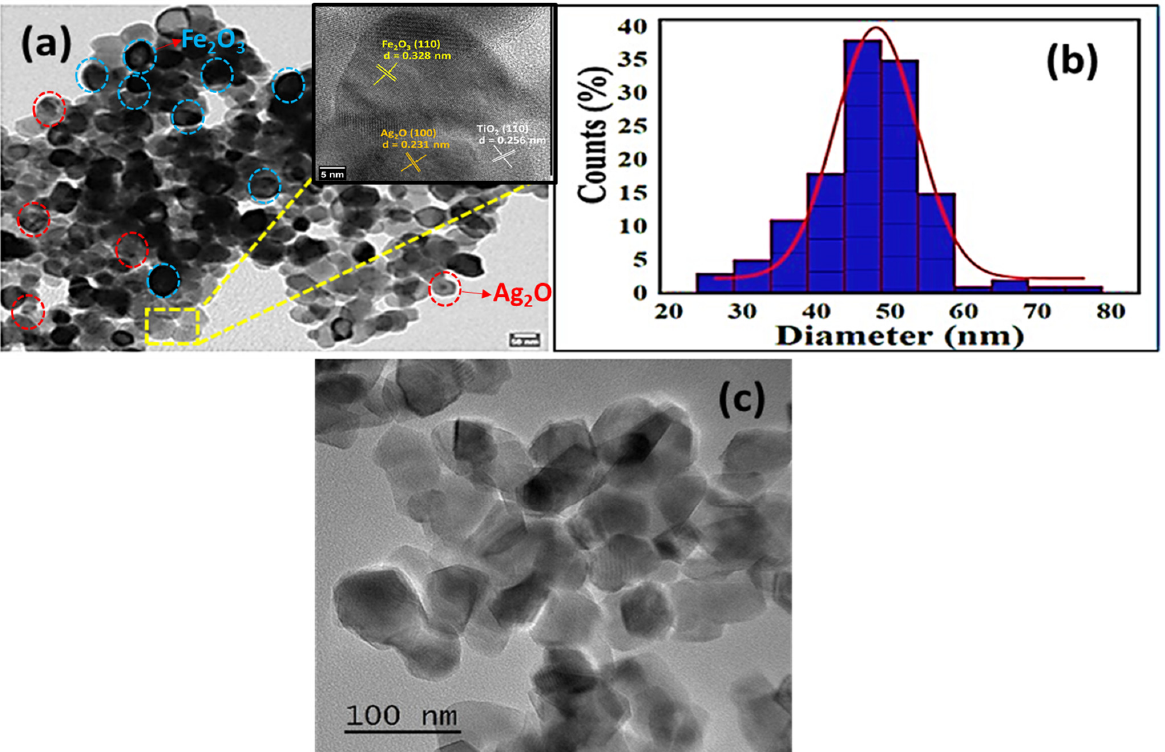
Figure 5. ( a ) TEM image of Fe 2 O 3 -Ag 2 O/TiO 2 nanocatalyst, where inset shows the HRTEM image; ( b ) size distribution curve of Fe 2 O 3 -Ag 2 O/TiO 2 ; ( c ) TEM image of TiO 2 nanocatalyst.